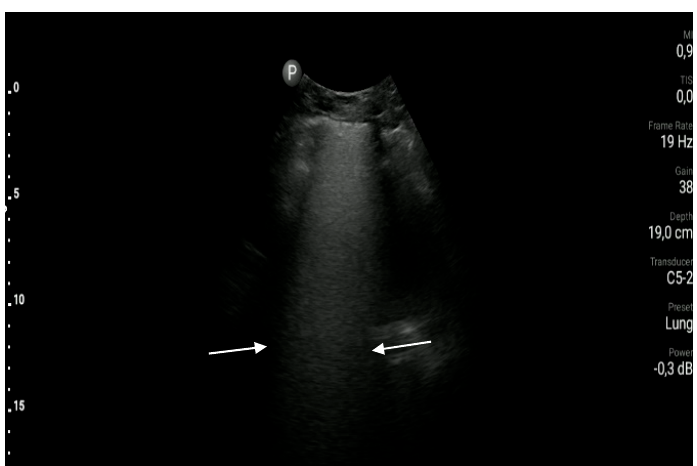
Figure 5. So called “white lung”, a significant number of B-lines which cannot be visualized separately (area between white